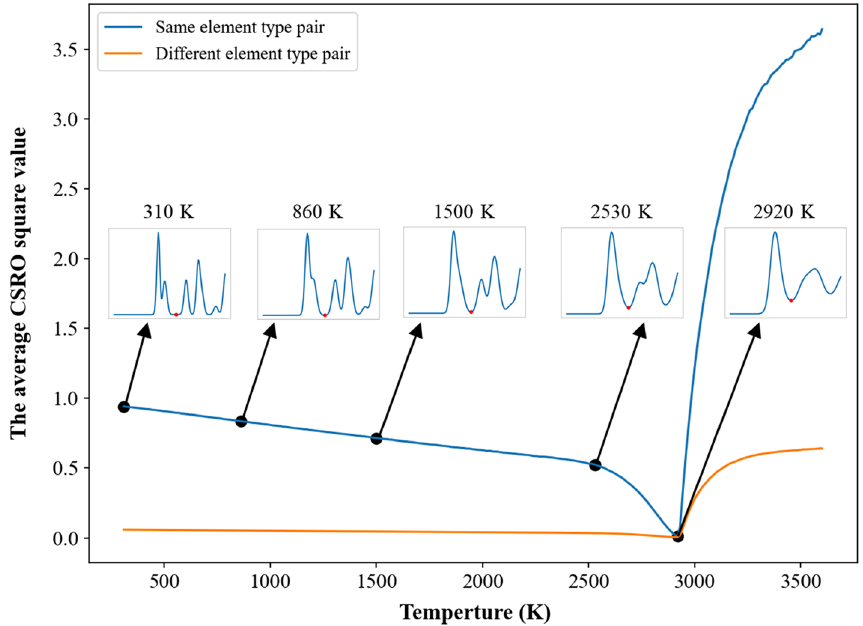
Figure 7. Average CSRO square profiles of the same and different element type pairs for the single crystal the short-ranged order values of the same element type pairs are about 0.75, which are smaller than the cor- responding values about 0.98 shown in Fig. 3. For the pairs of different element types, the short-ranged order values are very similar to those shown in Fig. 3. At 2920 K, it can be seen from Fig. 8a that the absolute values of all short-ranged order pairs become very small, and the short-ranged order values of the same element pairs are very close to 0. At the melting point of 2940 K and 3110 K, most short-ranged order values show considerable changes as compared to those at 2530 K and those of 300 K shown in Fig. 3. For investigating the short-ranged order change between 300 and 3110 K, Fig. 8b shows the differences of all short-ranged order pairs between 300 and 3110 K. The values in Fig. 8b are the short-ranged order values at 3110 K subtract the corresponding short- ranged order values at 300 K. Consequently, the positive value of short-ranged order difference stands for the chemical affinity of an element type pair becomes weaker, whereas the negative value indicates the affinity of an element type pair becomes stronger. In Fig. 8b, one can see the short-ranged order differences of the same element type pairs are negative, indicating the affinity of the same element undergoes significant change at temperatures higher than the melting point. Figure 9 shows the atom distributions of Nb, Mo, W, Ta, and V within the single crystal Nb positive, indicating these element pairs become less affinity after the structural rearrangement after the melting. Figure 10a,b show the displacement vectors of all atoms at the melting temperature of 2940 K and 3110 K, respectively. The structure at 300 K is used as the reference structure to determine the atomic displacement vec- tors using OVITO. At 2940 K, one can see the displacement vector lengths of most atoms are longer than those in thermal vibration (marked in blue), indicating these atoms are far away from their equilibrium positions. At 3110 K, the displacement vector lengths of all atoms become much longer and the local structure is under significant change. The SD and binding energy profiles of atoms within the grain and GB during the temperature elevation are shown in Fig. 11a,b for the case with the grain size of 25.3 nm, respectively. For the profiles of binding energy, both the values of grain and GB increase linearly with the increasing temperature from 2100 to 2800 K and from 2100 to 2670 K. Then binding energies of grain and GB display parabolic increase from 2800 to 2920 K and from 2670 to 2820 K, respectively. At temperatures higher than 2800 K for grain and 2670 K for GB, SD values begin to rise dramatically, indicating the local structural rearrangement occurs at these temperatures. It can see the temperature for GB structural rearrangement is relatively lower than that of grain. Consequently, at 2820 K, most GB atoms have enough kinetic energies to leave their equilibrium positions, and then these GB atoms gradually induce the rearrangement of grain atoms close to GB. Consequently, the temperature of 2820 K can be regarded as the pre-melting temperature, at which the melting of GB has been completed. When the temperatures con- tinuously increase from 2920 to 3100 K for grain and from 2820 to 3100 K for GB, the binding energies decrease with the increasing temperature, and it indicates atoms of the same element types have a higher opportunity to contact each other. It should be noted the temperature, 2920 K (very close to the melting point obtained from enthalpy profile), is located at the binding energy peak of grain atoms, and it indicates most grain atoms have